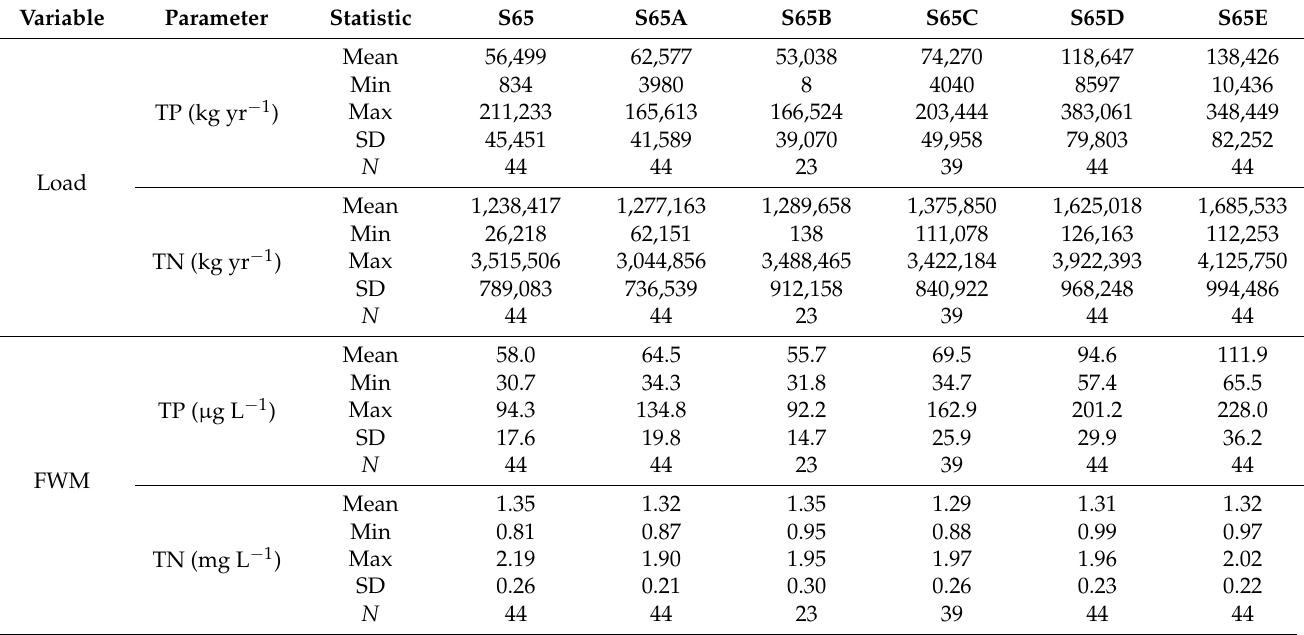
Table 2. Total phosphorus (TP) and total nitrogen (TN) annual load and flow-weighted mean (FWM) concentration summary statistics for water control structures along the Kissimmee River floodplain. Summary statistics include arithmetic mean (mean), minimum (min), maximum (max), standard deviation (SD), and sample size ( N ).